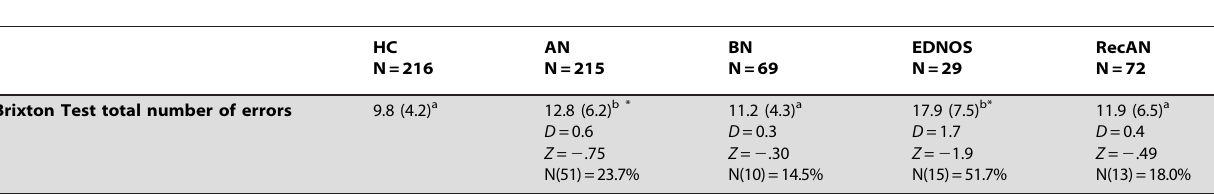
Table 2. Number of Errors made on the Brixton Test for the Healthy Control (HC), Eating Disorder (AN, BN and EDNOS) and Recovered AN (Rec AN)